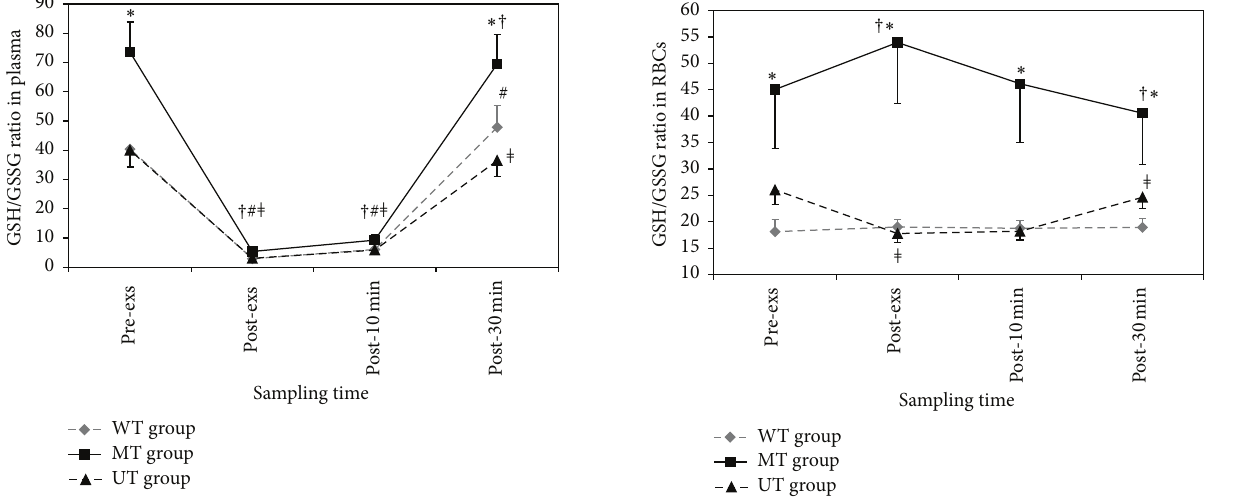
Figure 3: Effects of one session of aerobic exercise on GSH/GSSG ratio in red blood cell (RBC) in subjects with different physical training status: values represent mean ± SEM ( 𝑛 = 10 ) for each time point. ∗ ( 𝐹 = 4.176, 𝑝 = 0.026 ) MT group versus WT and UT groups in pre- and post-exs ( 𝐹 = 9.202, 𝑝 = 0.001 ), post-10min ( 𝐹 = 5.890, 𝑝 = 0.008 ), and post-30min ( 𝐹 = 3.737, 𝑝 = 0.037 ); † MT group by time ( 𝑝 < 0.001 ); (cid:2) UT group by time ( 𝑝 = 0.006